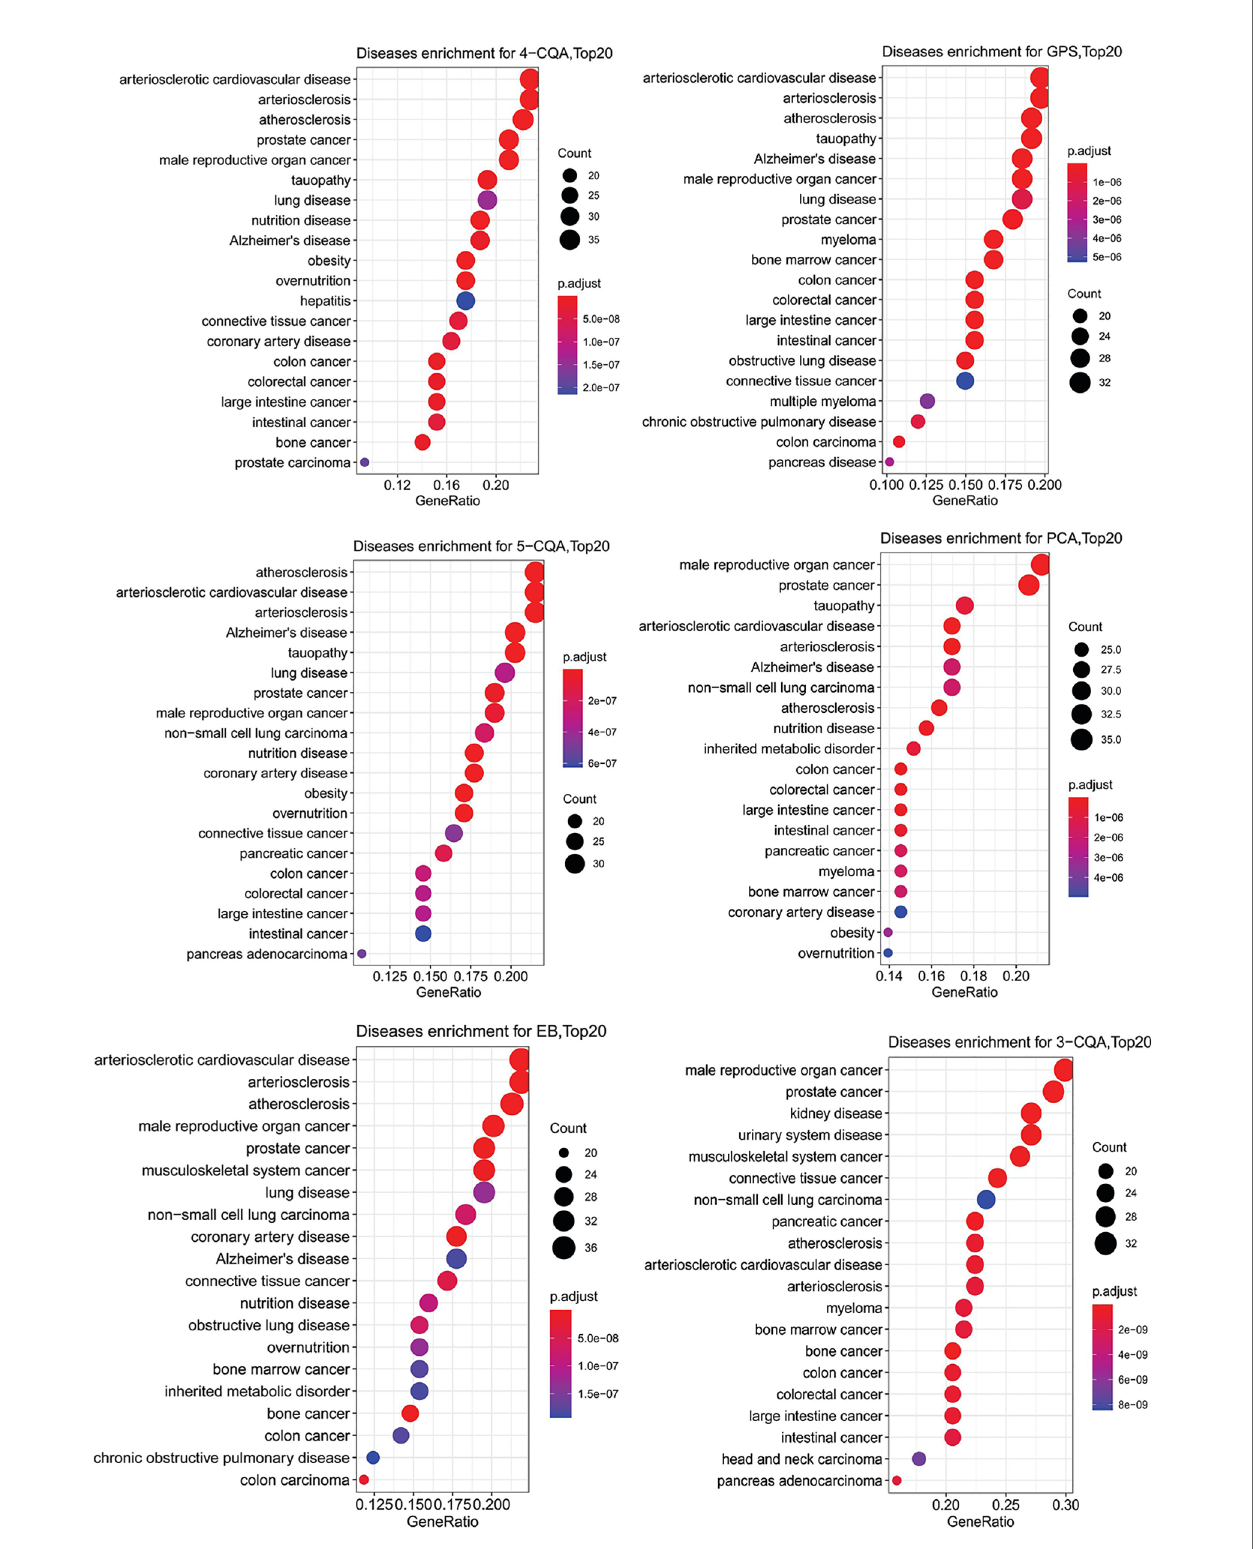
FIGURE 5 | Dotplots of diseases ontology (DO) enrichment analysis (Top20 results) for the six ingredients, 4-CQA, gentiopicroside (GPS), 5-CQA, protocatechuic acid (PCA), eleutheroside B (EB), and